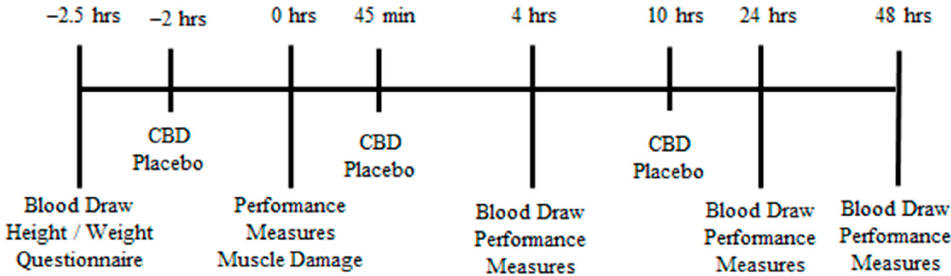
Figure 1. Study timeline for a given treatment. CBD = Cannabidiol; hrs = hours.